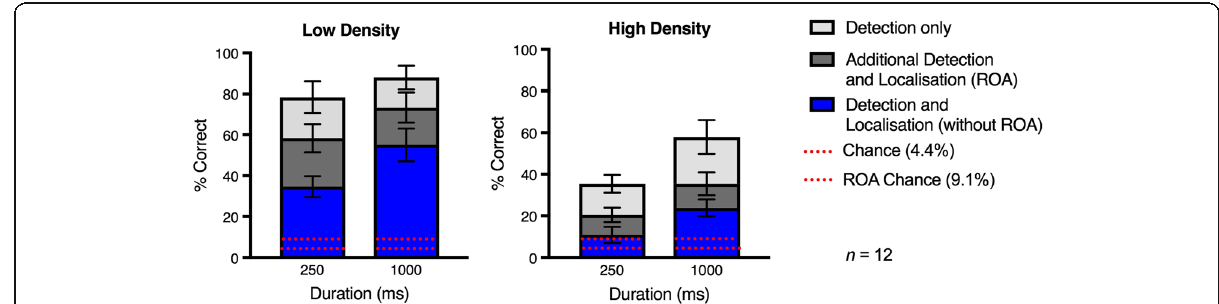
Fig. 7 Percentage correct detection and localisation on target-present trials for low- and high-density mammograms plotted by duration (250 ms, 1000 ms). Data are separated by response accuracy: detection and localisation correct ( blue bar ); the additional proportion of trials where localisation is correct when a ROA is included ( dark grey bar ); and detection correct/localisation incorrect ( light grey bar ). Error bars represent 95% confidence